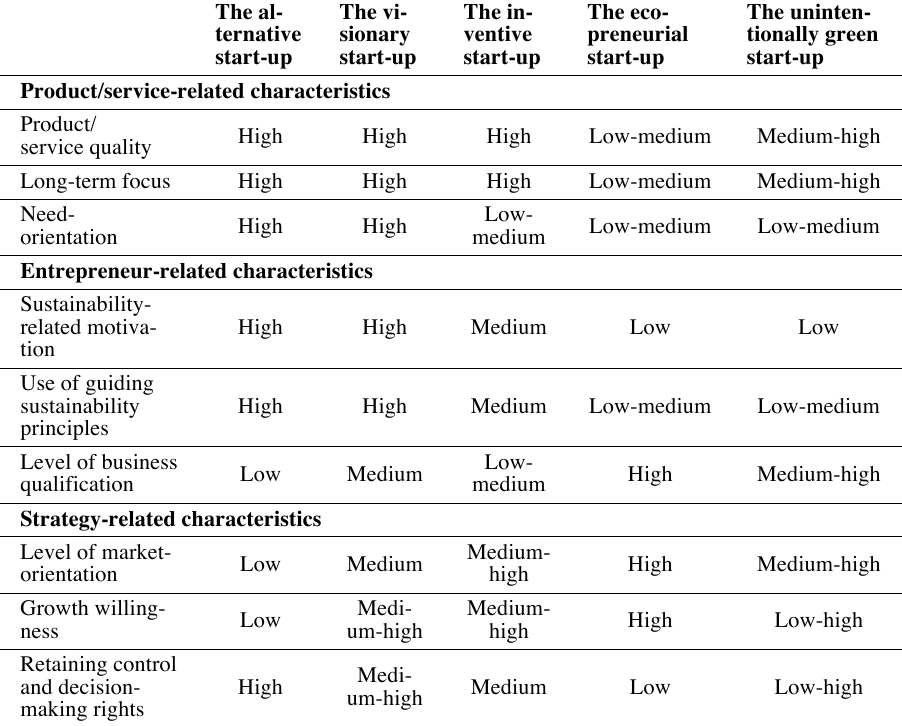
Table 4. Matching characteristics with types of green start-ups